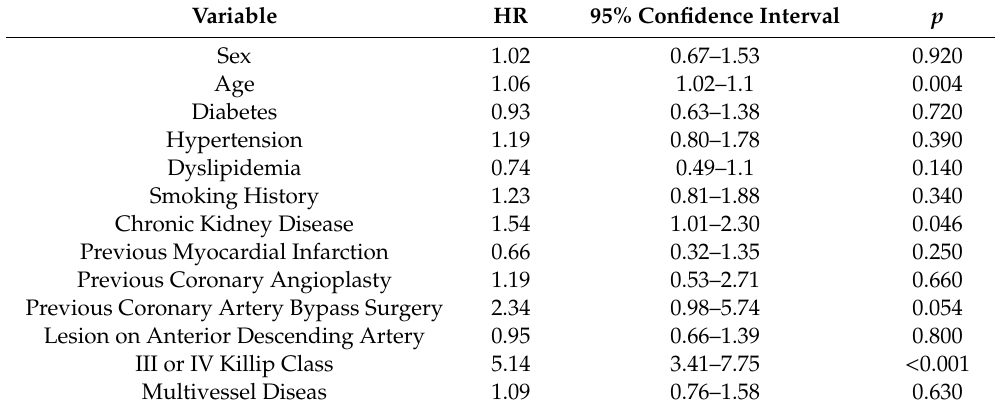
Table 6. Multivariable